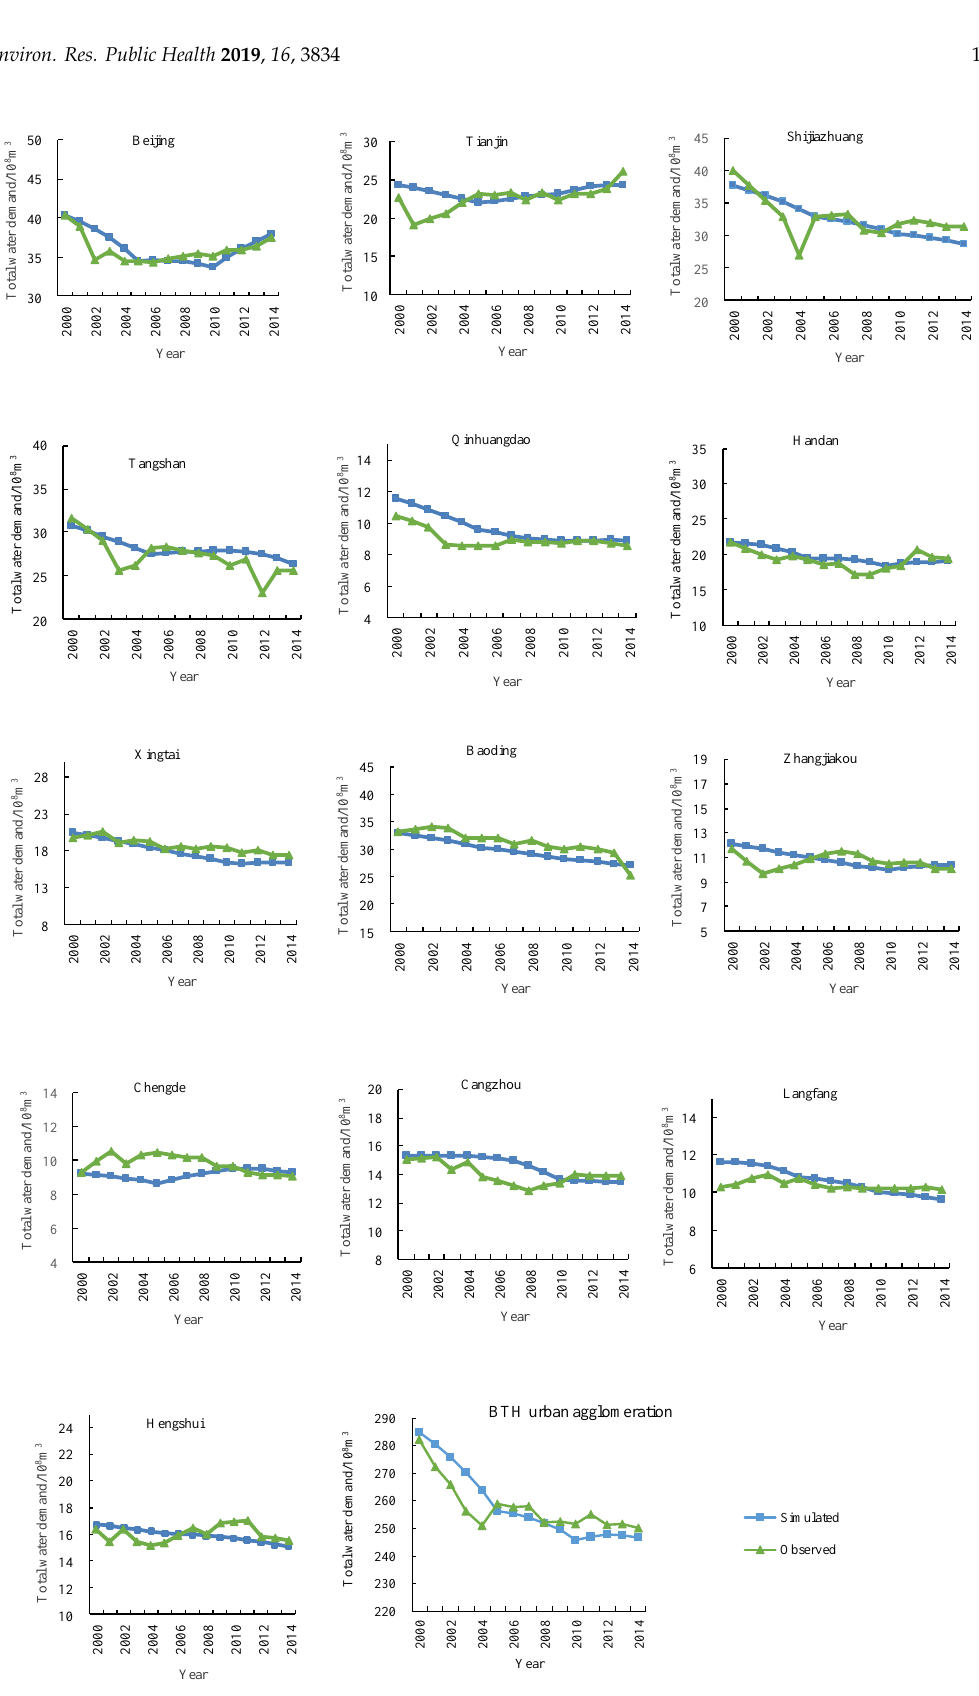
Figure 5. The comparison between observed and simulated results of total water demand in 13 cities in the Beijing–Tianjin–Hebei (BTH) urban agglomeration.